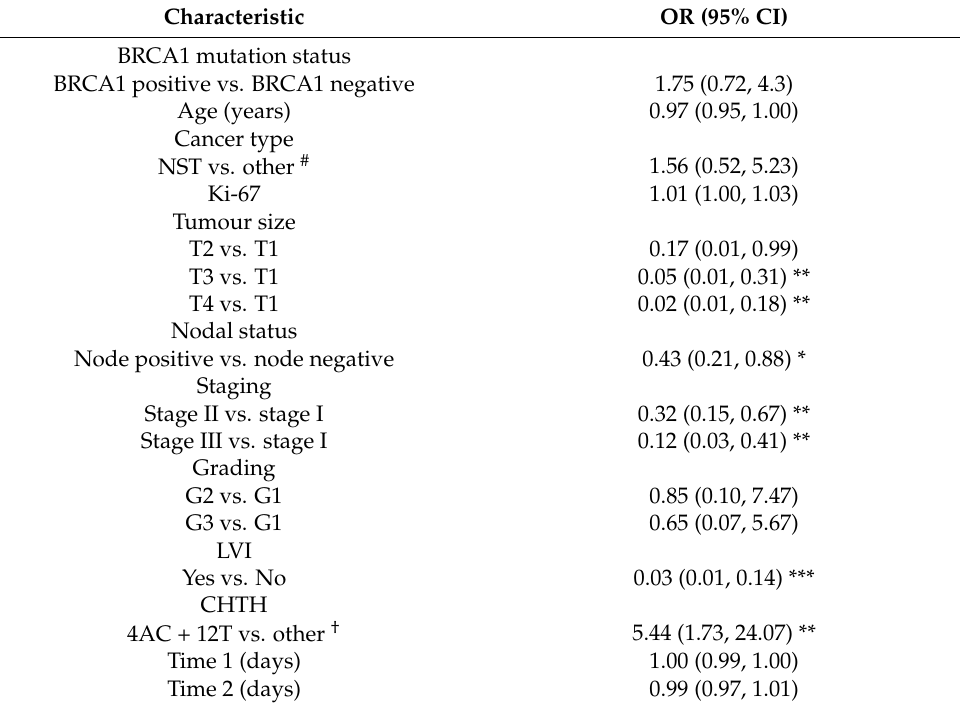
Table 3. ORs (95% CIs) of pCRs vs. non-pCRs associated with clinico-pathological factors. Characteristic OR (95% CI) BRCA1 mutation